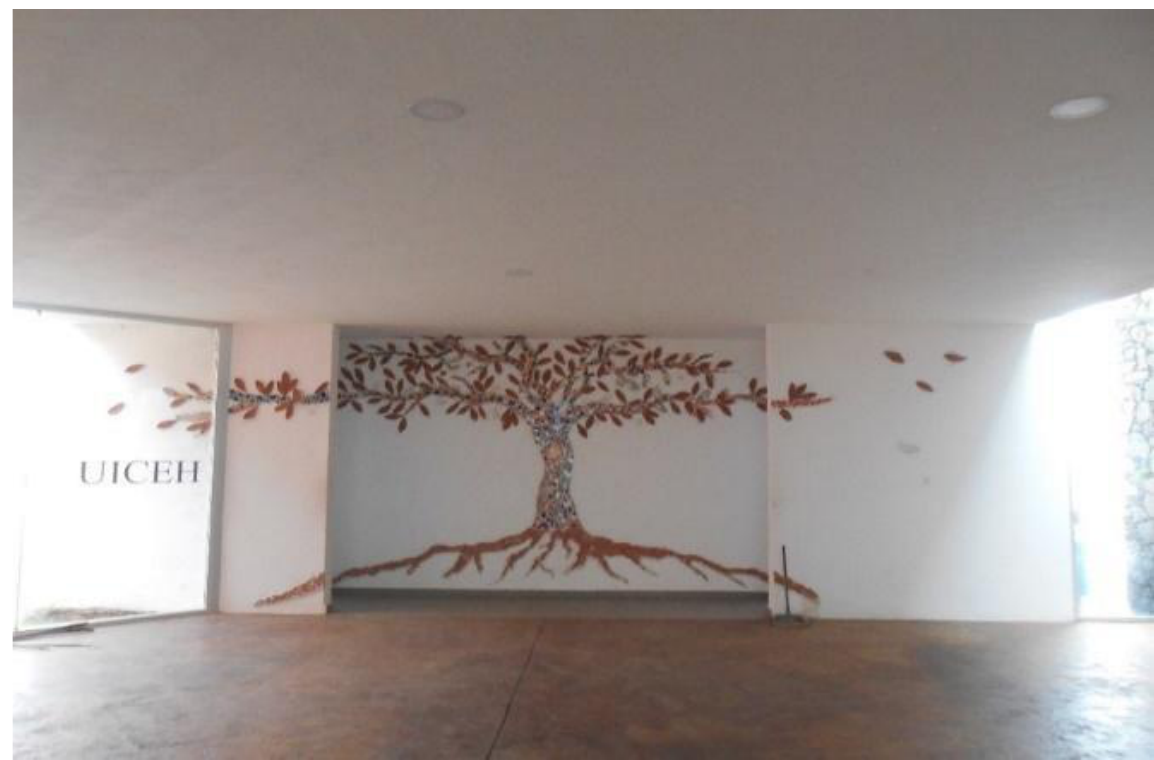
Figure 7, Women's and men's restrooms and a mosaic mural at the entrance Source Dalia Peña